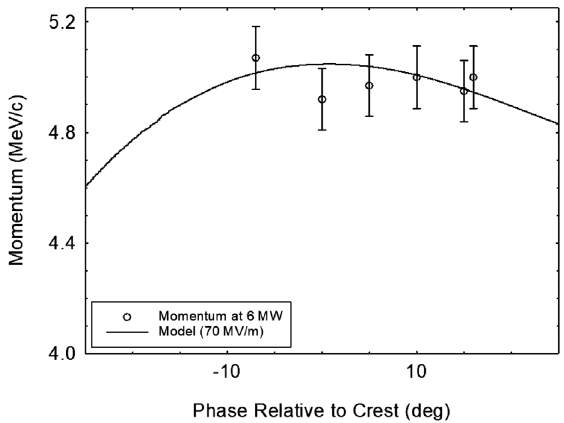
FIG. 35. Measured momentum as a function of the linac